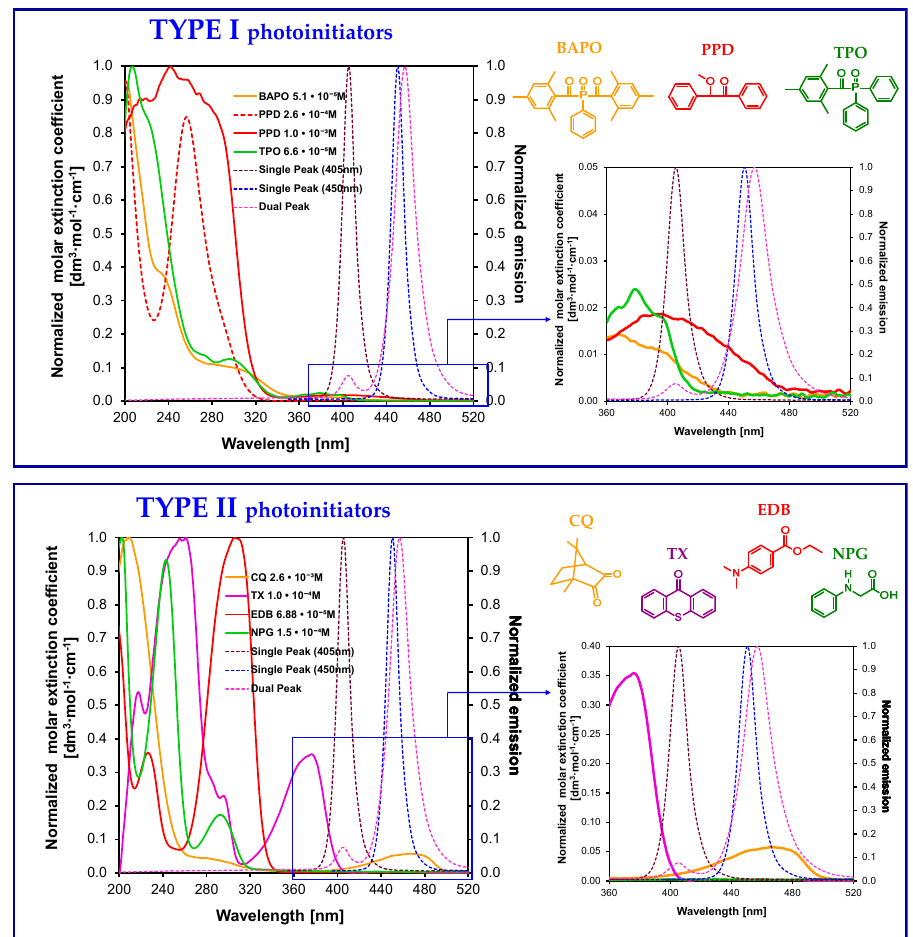
Figure 7. Comparison of the normalized molar extinction coefficient of standard type I initiators (top) and type II initiators together with amines (bottom) used in dental applications with the emission characteristics of standard light-curing units.